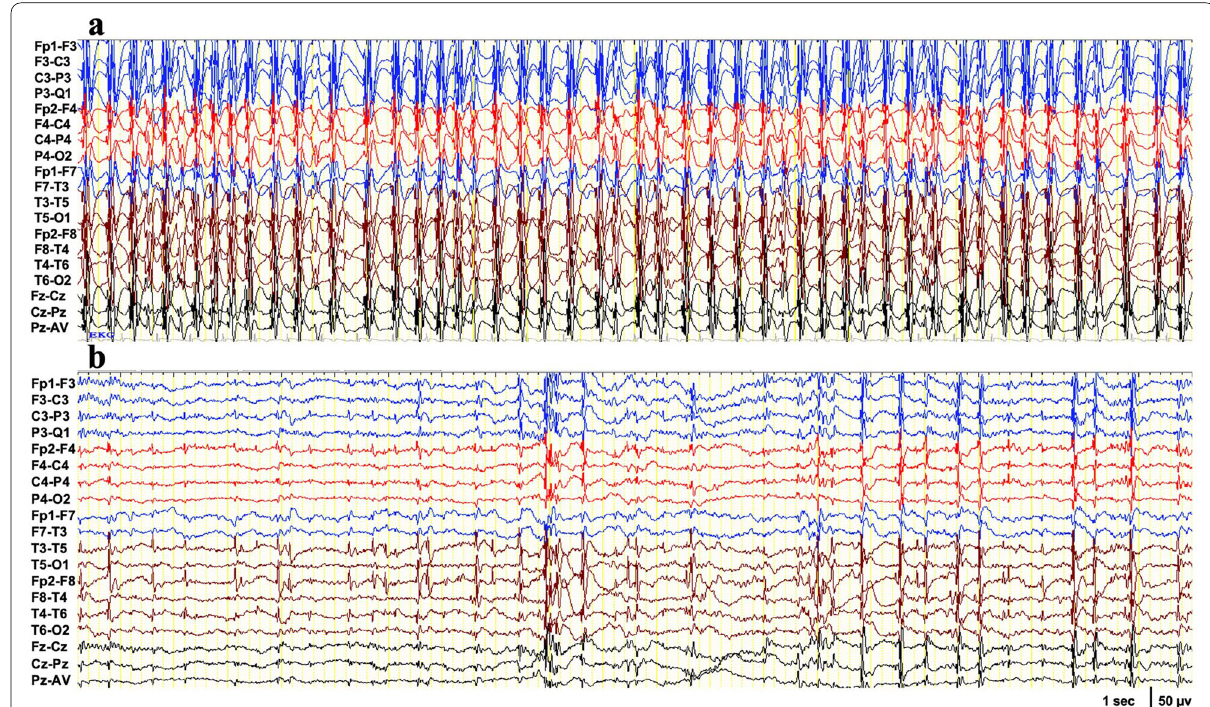
Fig. 1 ( a ) Interictal electroencephalogram demonstrating electrical status during sleep (spike-wave index over 85%) with posterior-temporal predominance before methylprednisolone treatment. ( b ) Interictal electroencephalogram demonstrating posterior-temporal discharges (spike-wave index below 50%) after methylprednisolone